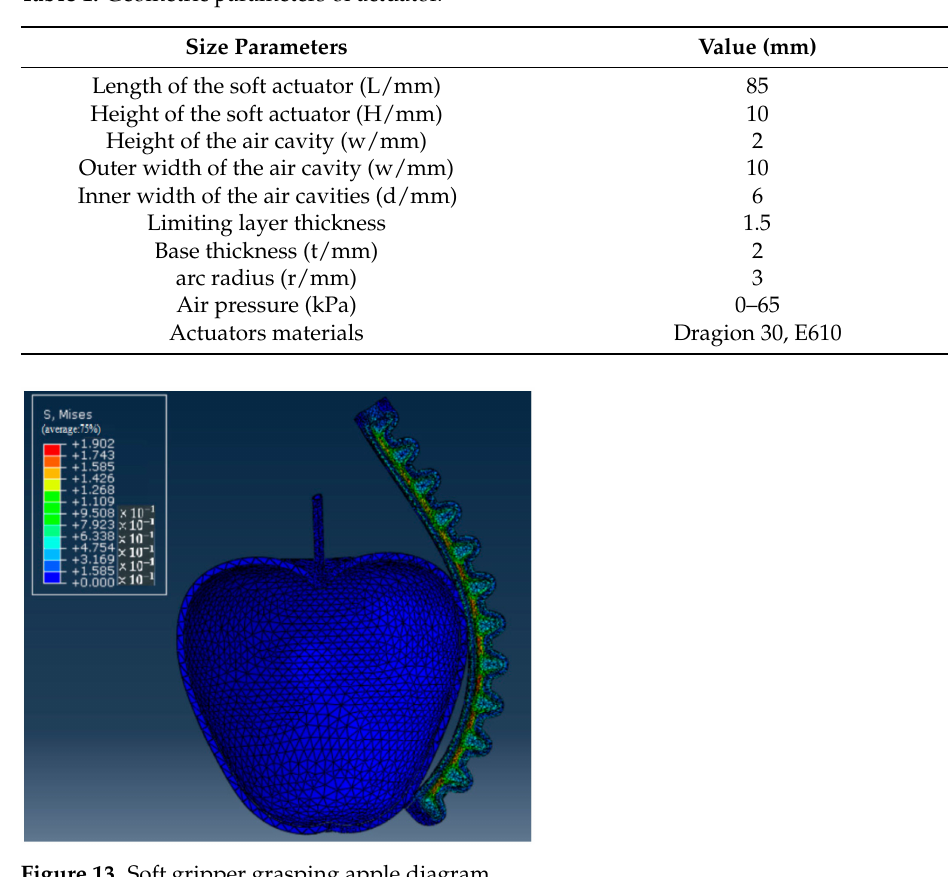
Table 1. Geometric parameters of actuator.